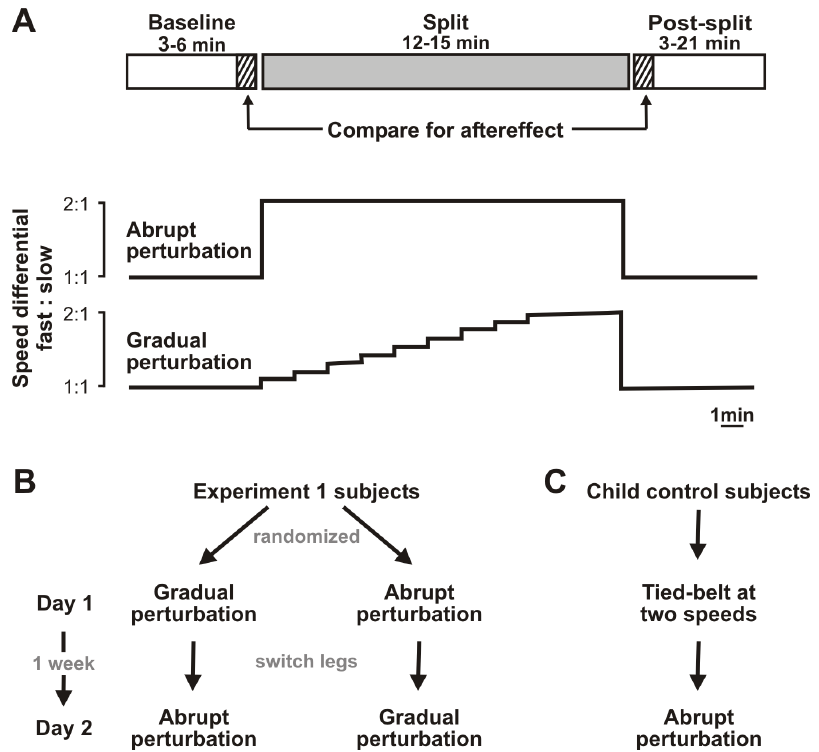
Figure 1. Experimental protocol and design. A. Top graph: Schematic of split-belt testing paradigm. During a single testing session, subjects experienced tied-belt walking for 3–6 minutes (Baseline), followed by 12–15 min period of split-belt walking (Split), and a final period of tied-belt walking (Post-split). Durations of periods were determined a priori (see text). Post-split duration ranged from 3–6 minutes for children, but was extended to 21 minutes for adult subjects. The hatched bars indicate the time points of the steps used for calculation of aftereffect. Bottom graph: Two methods of introducing the 2:1 belt speed differential: abruptly changing the fast belt, or gradually increasing the fast belt speed in increments of 0.045 m/s over the first L of the split-belt period, then maintaining the 2:1 ratio for the final J of the split-belt period. B. Subject allocation to the two sequences (abrupt or gradual) of testing in Experiment 1. The leg on the fast belt was switched between Day 1 and Day 2. C. Child control subjects (Experiment 2) were exposed to tied-belt walking at two speeds on Day 1, and to split-belt walking (abrupt perturbation) on Day 2.